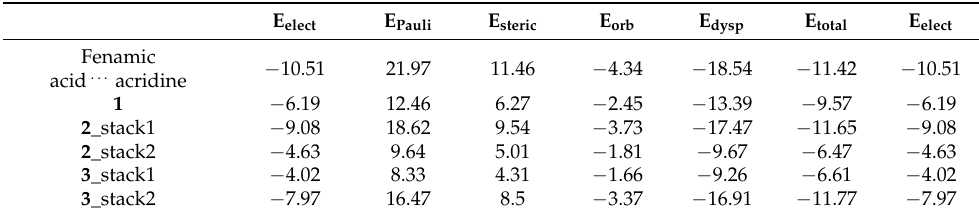
Table 5. Decomposition of the interaction energy for stacking acridine molecules in the complexes of fenamic acids with acridine in